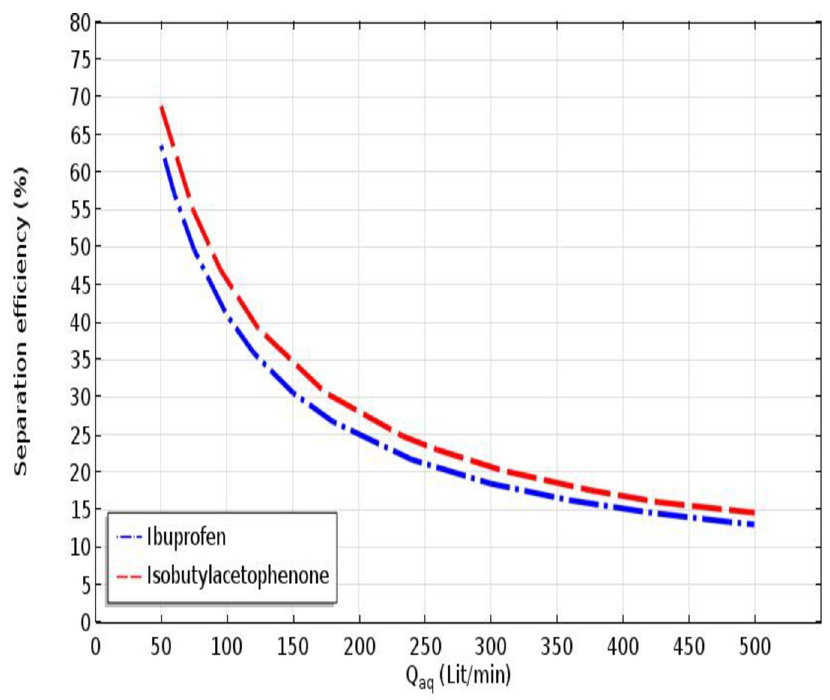
Fig 7. Effect of aqueous solution flow rate on ibuprofen and isobutylacetophenone solutes molecular separation.